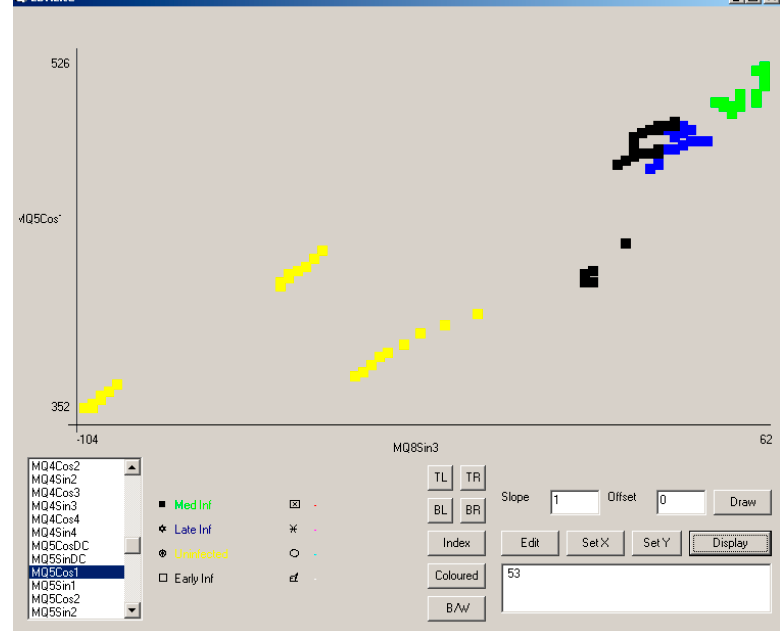
Figure 12. Separation of sample type using MQ5 Cos1 and MQ8 Sin3 across all three experiments. Responses from uninfected (HS) samples are plotted in yellow, from early infection (ES) in black, from moderate infection (MS) in green, and from late infection (LS) in blue. The use of other coe ffi cients can be used to distinguish fresh air,